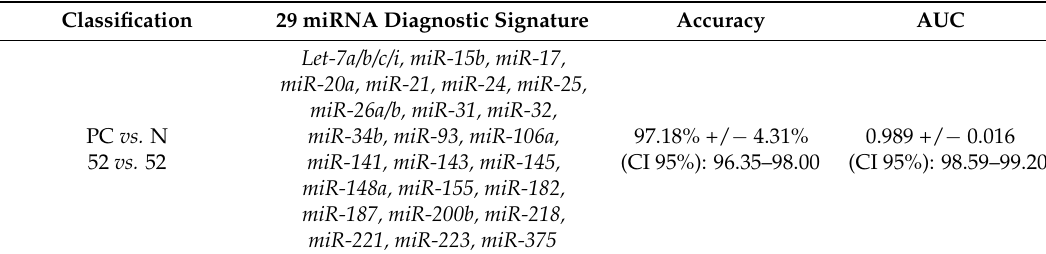
Table 3. Accuracy and Area Under the Curve (AUC) for the 29 miRNA diagnostic signatures. CI = confidence interval; PC = prostate cancer; N = normal sample Classification 29 miRNA Diagnostic Signature